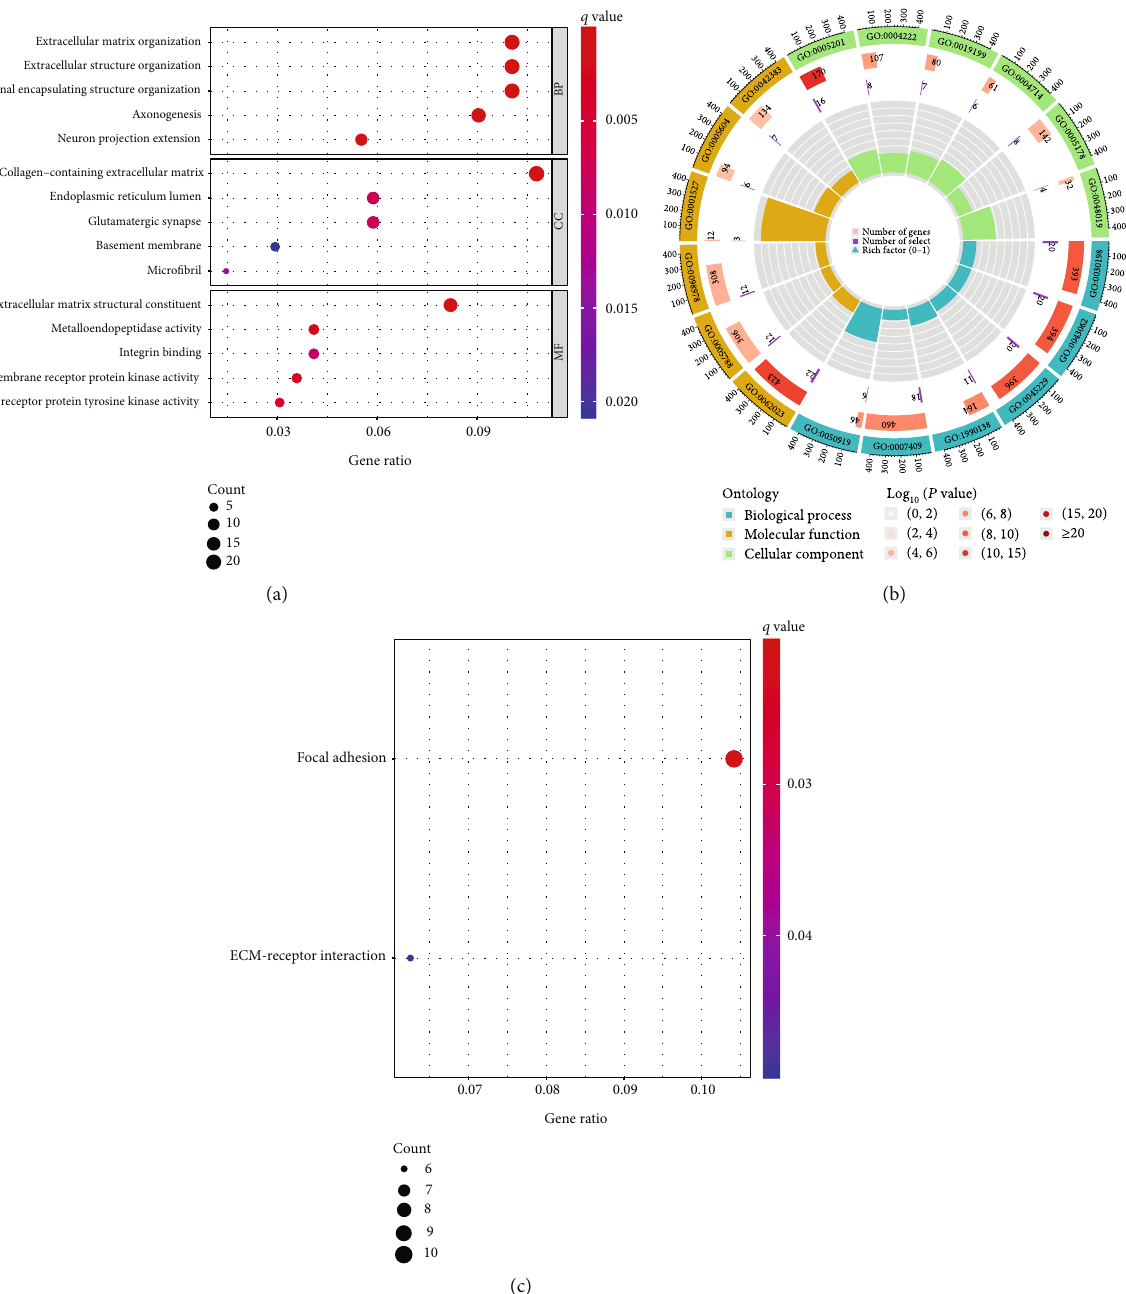
Figure 7: Functional enrichment analysis of DEGs in ESCA. (a, b) The GO analysis-identi fi ed biological processes with an abundance of DEGs. (c) KEGG analysis reveals enhanced pathways for